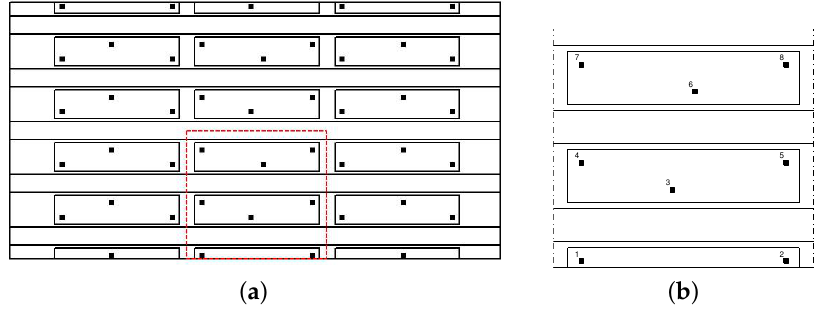
Figure 4. ( a ) Main panel with the one-sixth portion extraction; ( b ) one-sixth portion with eight possible sensor